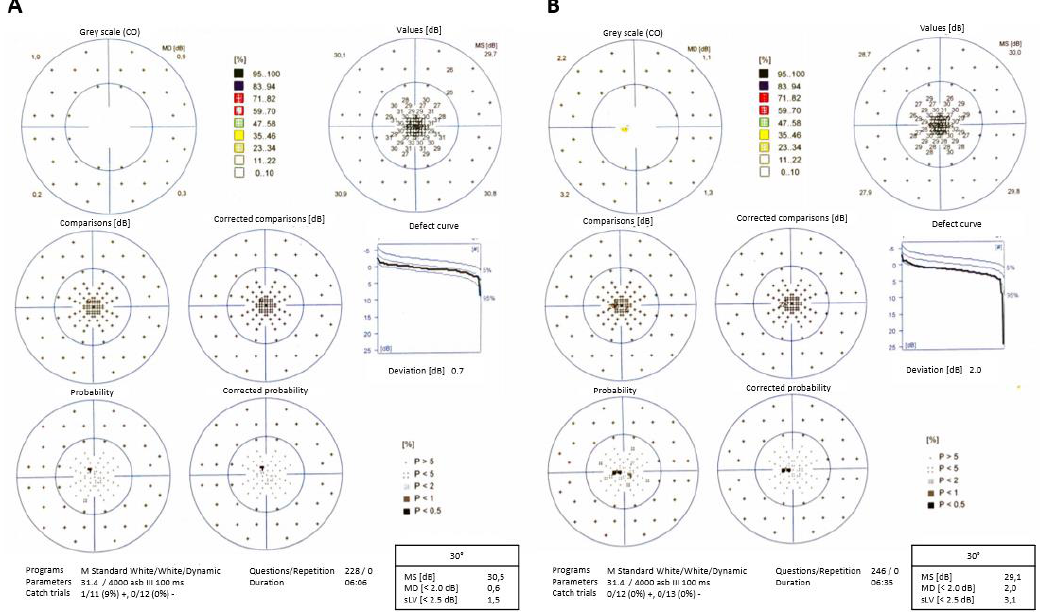
Figure 3. Visual field at presentation of right eye ( A ) and left eye ( B ) shows positive scotomas in the central region of both eyes.